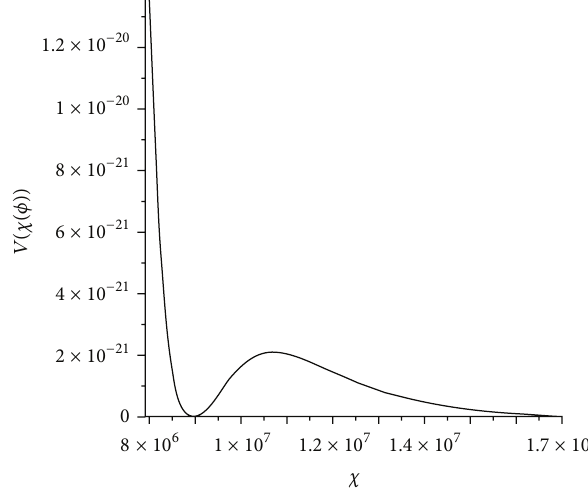
and one Figure 3: Solid line: mass spectrum of primordial BHs for the crit parameter values: 𝑐 5 = 8.9 ⋅ 10 12 , 𝑐 = 5.6 ⋅ 10 −6 𝐻 −2 , 𝑑 = 5 , = 12.89 ⋅ 10 −6 𝐻 −4 , 𝑏 = −8 ⋅ 10 −8 𝐻 6 , 𝑐 = 2𝐻 −2 , 𝑐 = −50𝐻 −2 , 𝑏 1 2 1 𝑉 = 1.069 ⋅ 10 7 𝐻 , ] [𝑑] = 10 3 , and 𝑚 = 4.4 ⋅ 10 4 𝐻 Λ = 0.0125𝐻 2 , 𝜒 . 0 𝐷 crit